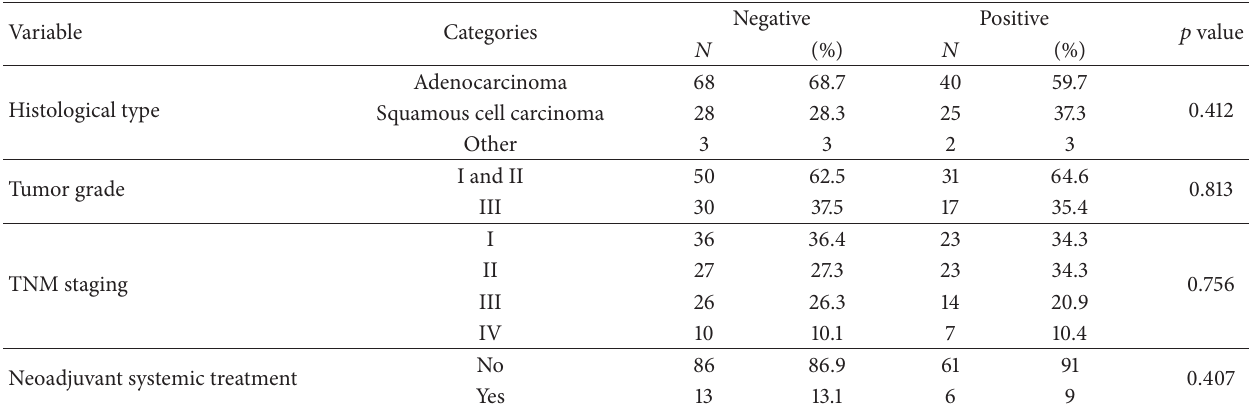
Table 8: PD-L1 expression in tumor cells and clinical data.